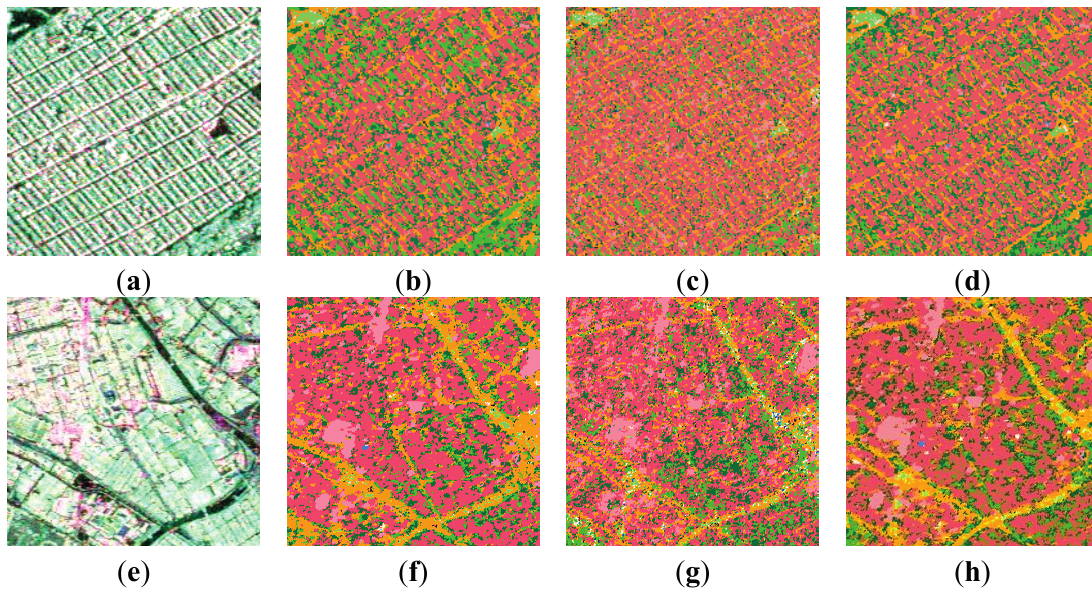
Figure 6. Comparison of classification results in two subsets marked in Figure